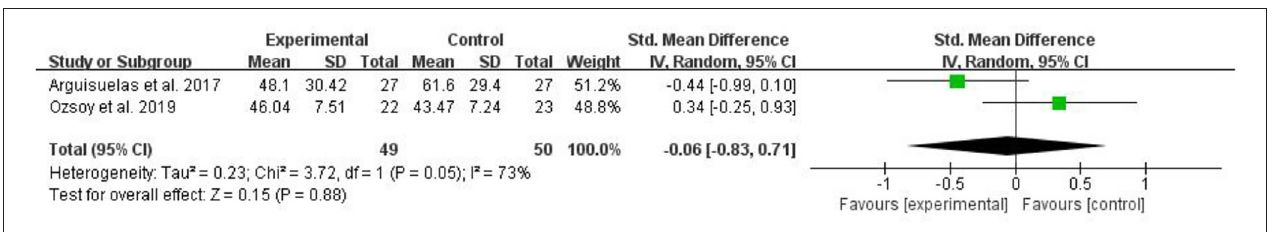
FIGURE 9 | Meta-analysis on mental